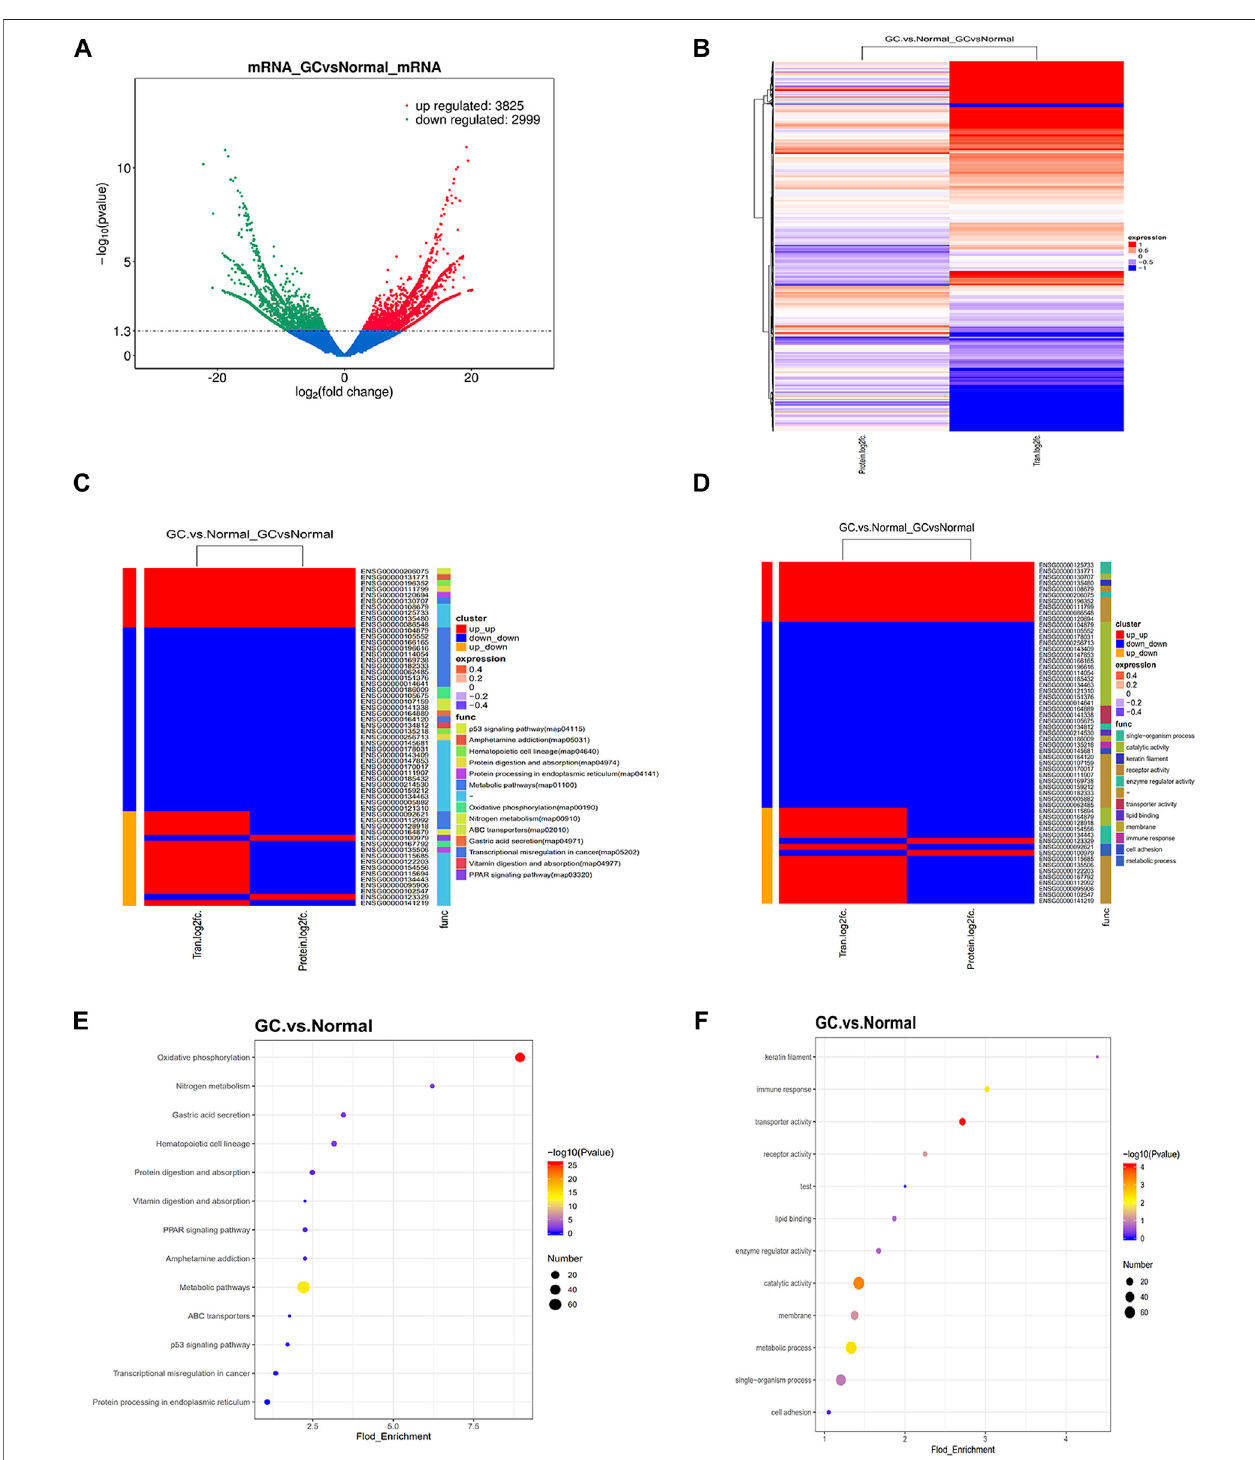
FIGURE 2 | Identi fi cation of coupled genes through complementary transcriptomics. (A) Volcano plot fi ltering of differently expressed mRNAs between GC and normal gastric samples. High expression level is indicated by “ red ” and low levels by “ green. ” (B) Heatmap illustrating the different expression in protein and mRNAs between GC and normal gastric tissue. The red part represents up-regulated protein (mRNA) and the blue part represents downregulated protein (mRNA). (C – D) Clustering heat map of GO and KEGG pathway enrichment presents the potential functions of signi fi cantly dysregulated proteins (mRNAs) both in proteomics and transcriptomics. The red and blue strips represent high and low expression, respectively. (E – F) GO and KEGG pathway enrichment present the potential functions of signi fi cantly dysregulated proteins (mRNAs) both in proteomics and transcriptomics. The Fold_Enrichment represents the protein (mRNAs) ratio of pathways.